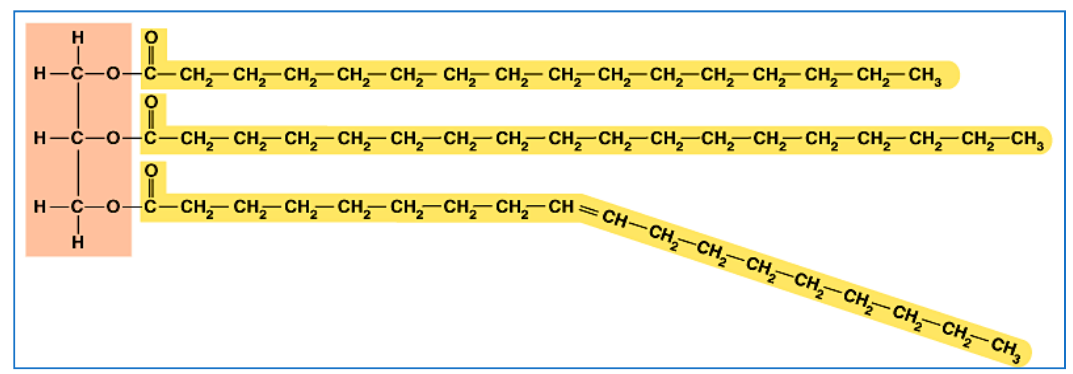
Figure 2. A typical triglyceride (natural oil or fat).